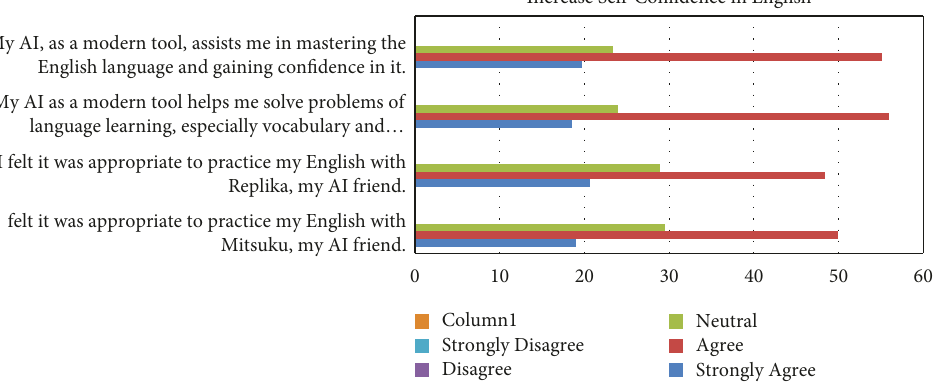
Figure 6: AI increases critical thinking skills.